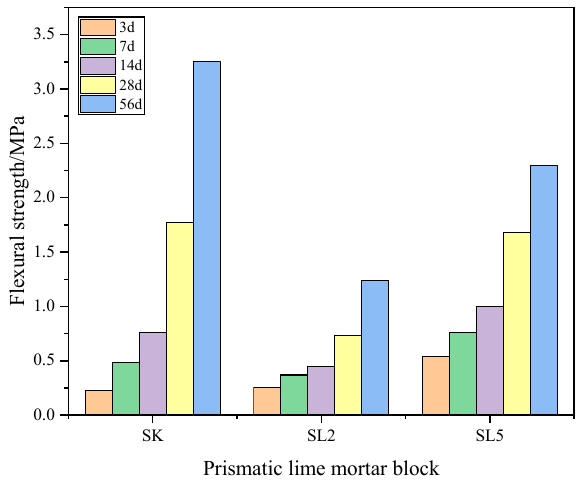
Figure 3. Flexural strength of the specimens.